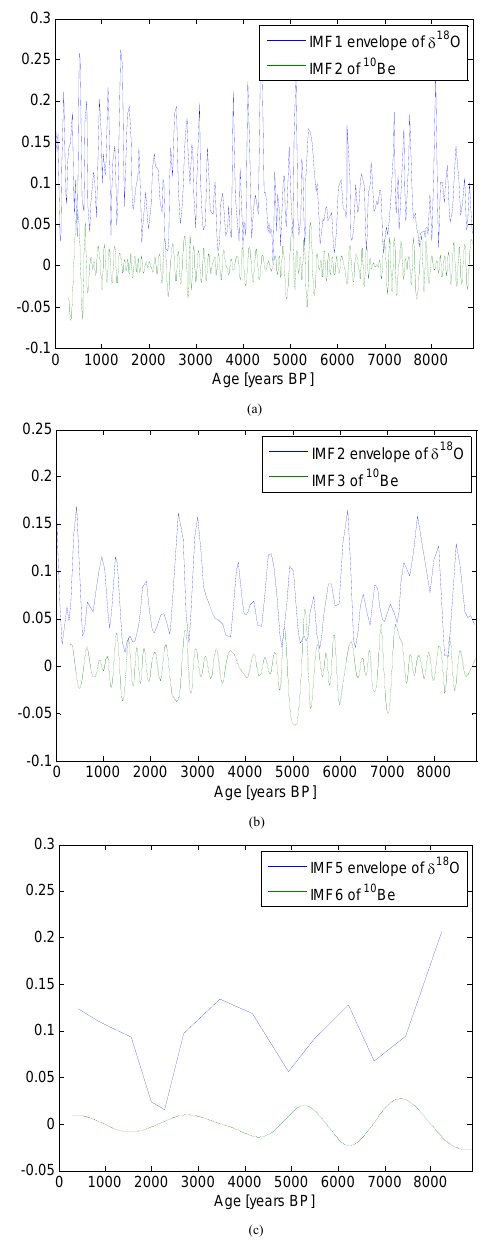
Fig.6 Fig. 6. Comparisons between the envelopes of IMFs of δ 18 O and IMFs of 10 Be. (a) IMF1 envelope of δ 18 O and IMF2 of 10 Be. (b) IMF2 envelope of 1 δ 18 O and IMF3 of 10 Be. (c) IMF5 envelope of δ 18 O and IMF6 of 10